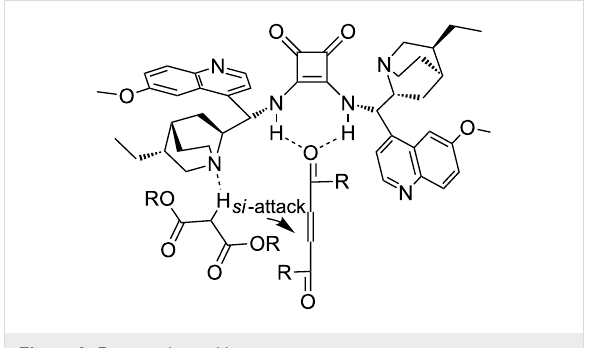
Figure 3: Proposed transition